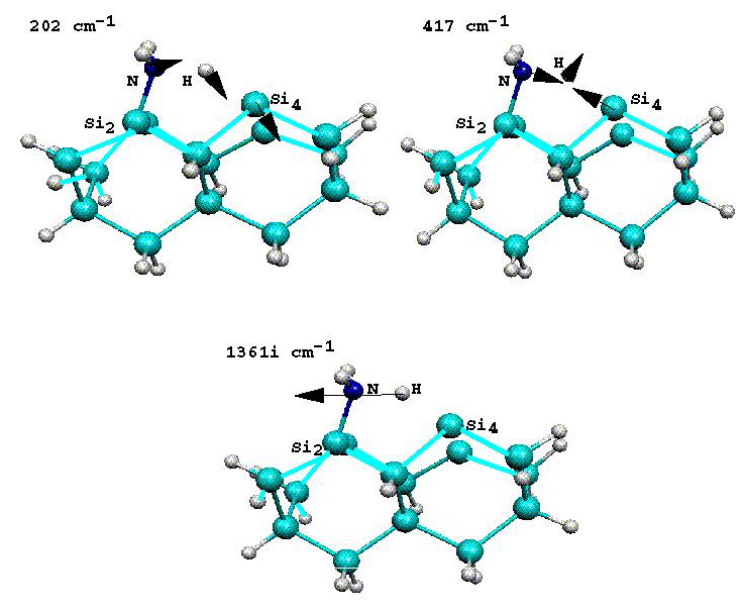
Figure 4. Normal modes most important for the hydrogen transfer between adjacen dimers. 202 cm -1 – the most active hindering mode, 417 cm -1 – the most active helping mode, 1361i cm -1 – the reaction